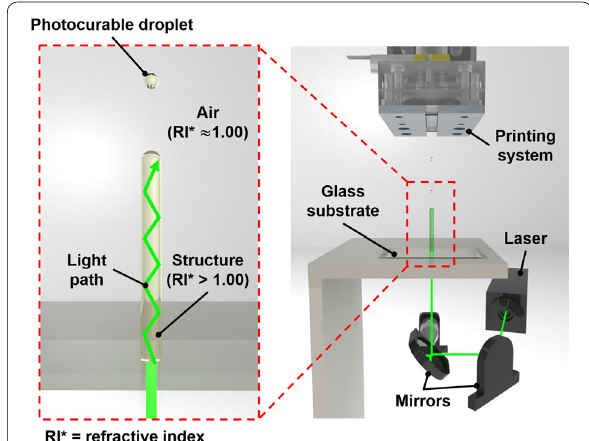
Fig. 1 Schematic diagram showing the principle and the system configuration of the new 3D printing method that utilizes in situ light as a